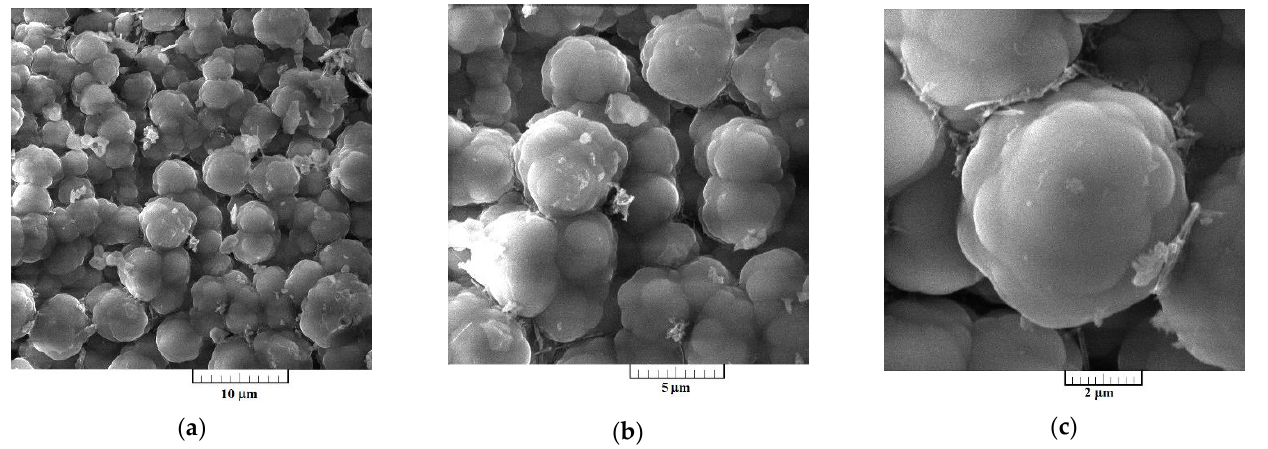
Figure 7. SEM micrographs of electrochemically produced Al‒V alloys from the equimolar AlCl 3 + NaCl melt containing anodically dissolved V at 0.020 V vs. Al, deposition time 5 h, at 200 °C; at: ( a , b ) low magnification and ( c ) higher magnification.